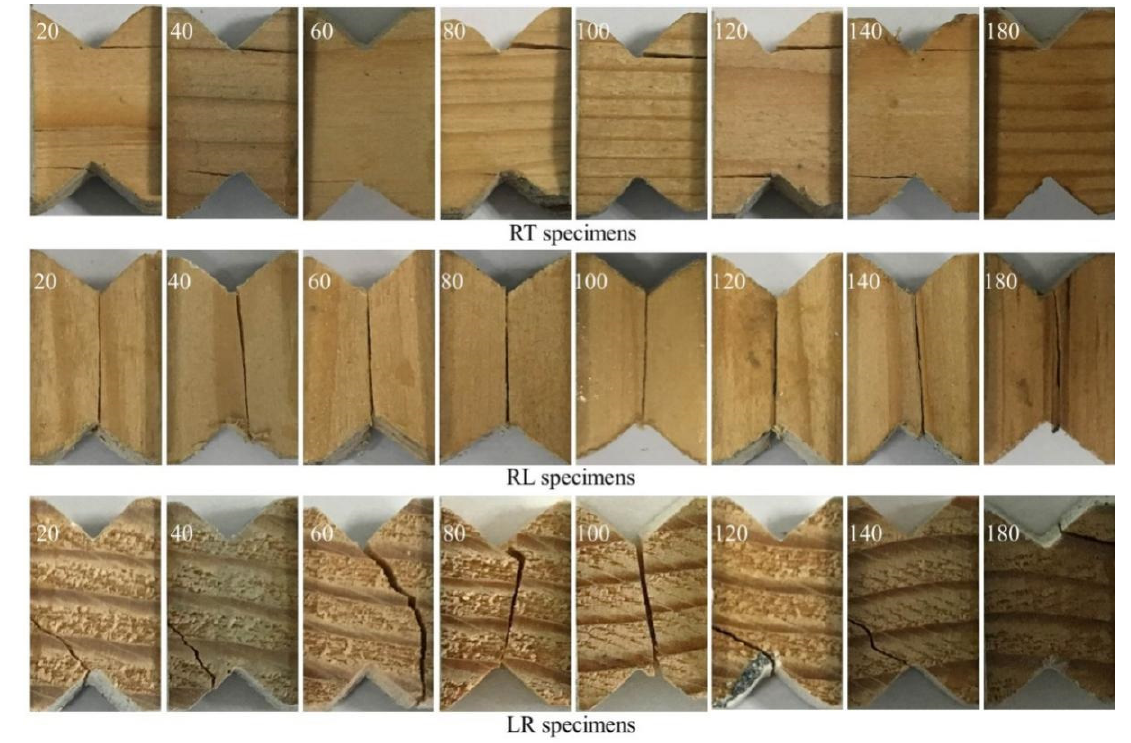
Figure 4. Shear failure modes of the specimens under elevated temperatures.